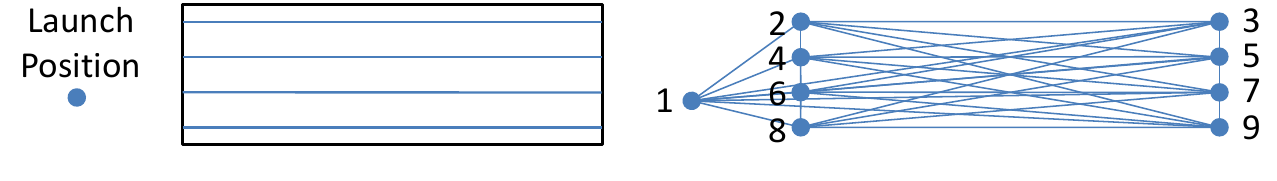
Figure 4. Graph representing the coverage problem. On the left, a rectangular region to be covered, the launch position and the covered rows. The nodes of the graph on the right are composed of the launch position and the intersection points between the coverage rows and the borders of the region. All nodes are connected by edges, forming a complete